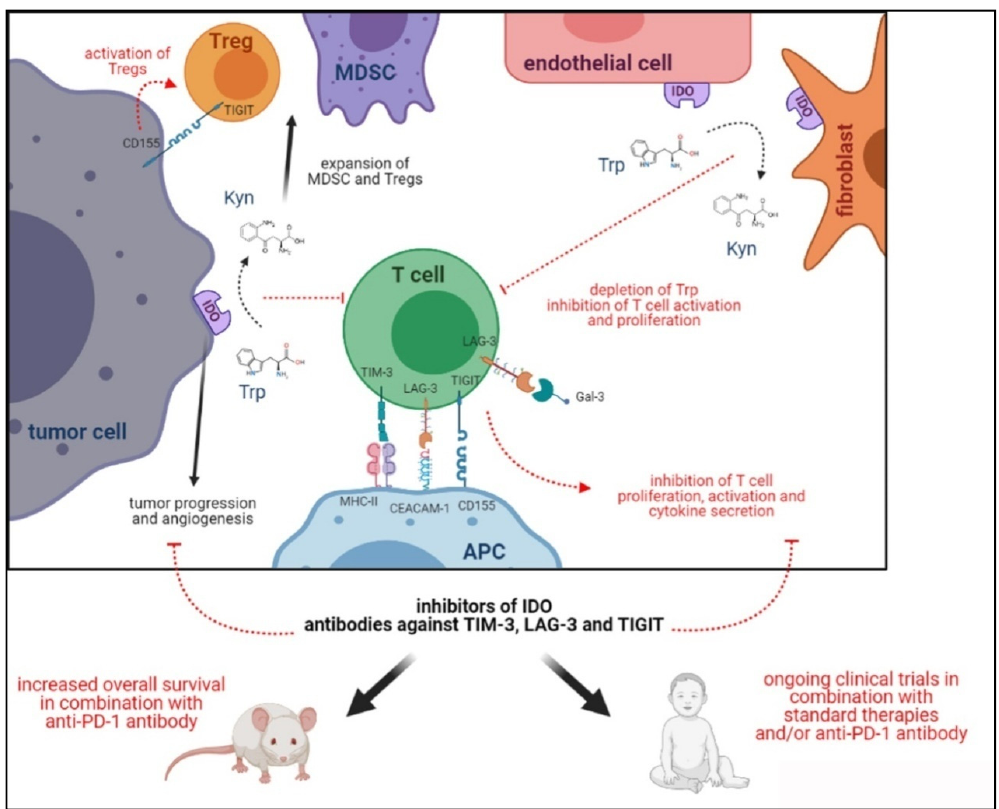
Figure 4. Expression of IDO-1, TIM-3, LAG-3 and TIGIT in TME and their immune suppressive